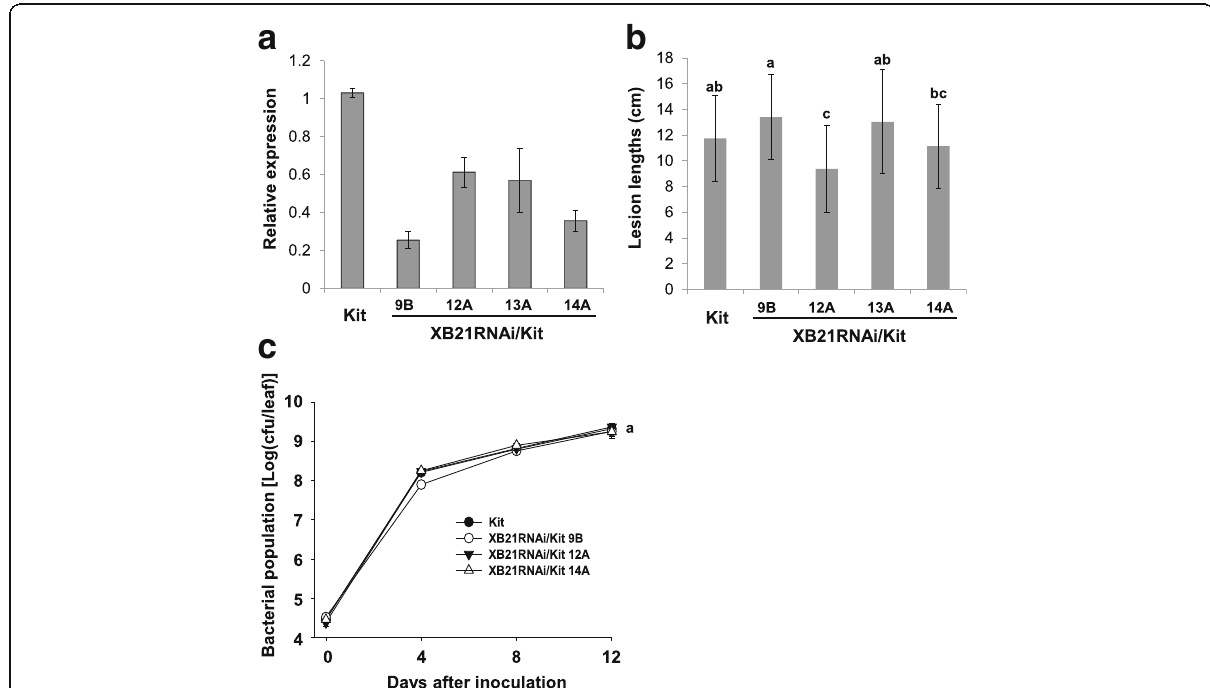
Fig. 5 Silencing of XB21 in Kitaake plants does not affect resistance to Xoo. a Relative expression of XB21 in Kitaake plants silencing XB21 . qRT-PCR was performed with specific primers for each genes. Gene expression level was normalized using ubiquitin as an internal reference. b Lesion lengths measured 14 days after inoculation from Kitaake plants silencing XB21 (XB21RNAi/Kit 9B, 12A, 13A, and 14A) and Kitaake plants. The error bars represent standard error between three biological replicates. c Xoo populations were monitored over 12 days in XB21RNAi/Kit (9B, 12A-2, and 14A-2) and Kitaake wild type plants. For each time point, bacterial populations were obtained in three separate leaves for each genotype. The error bars represent standard deviation values obtained from the three